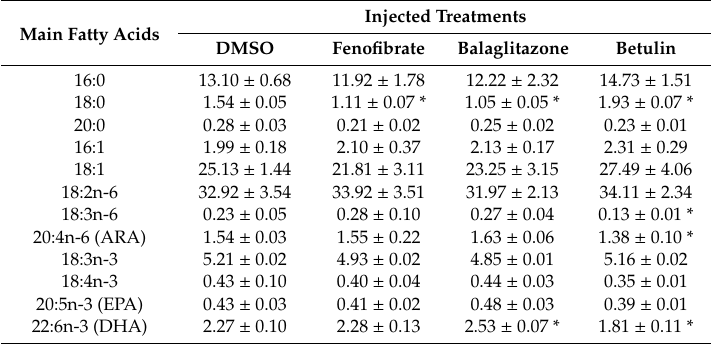
Table 1. Main fatty acids composition in muscle of common carp injected with siRNA, agonists (balaglitazone and fenofibrate), and antagonist (betulin) (% area). Injected Treatments Main Fatty Acids DMSO Fenofibrate